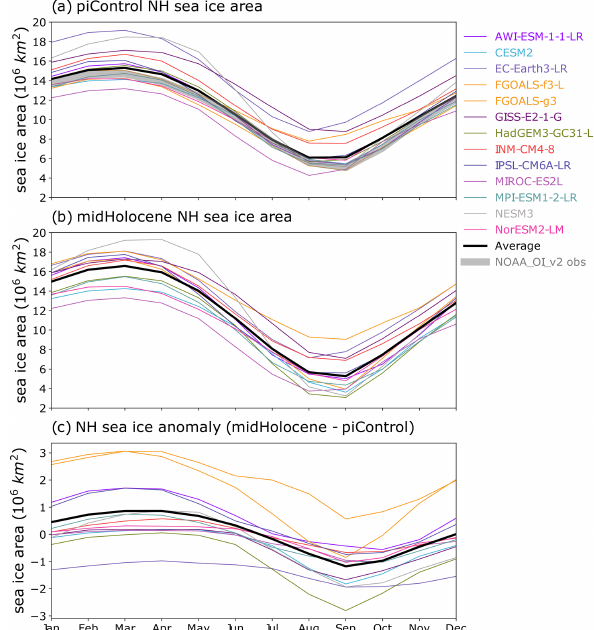
Figure 6. Annual cycle of the Arctic sea ice area (10 6 km 2 ) for (a) piControl, (b) midHolocene and (c) their anomaly (mid- Holocene − piControl), replotted from Fig. 17 of Otto-Bliesner et al. (2021). The grey line in panel (a) shows the observed monthly mean sea ice areas from the NOAA_OI_v2 dataset for 1982–2001 (Reynolds et al.,